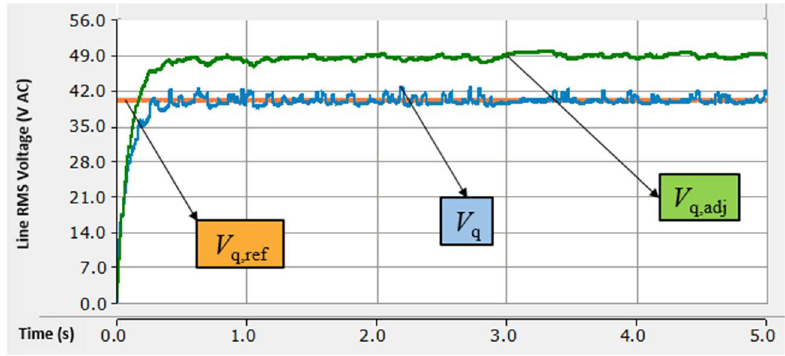
Figure 13. Voltage transients at the three-phase inverter’s output.